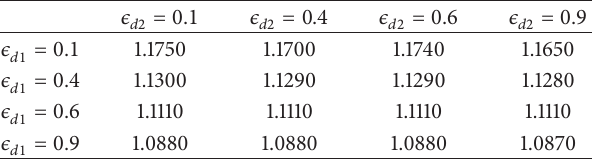
Table 5: The allowable range 𝛿 ran for different pair ( 𝜖 𝑑1 ,𝜖 𝑑2